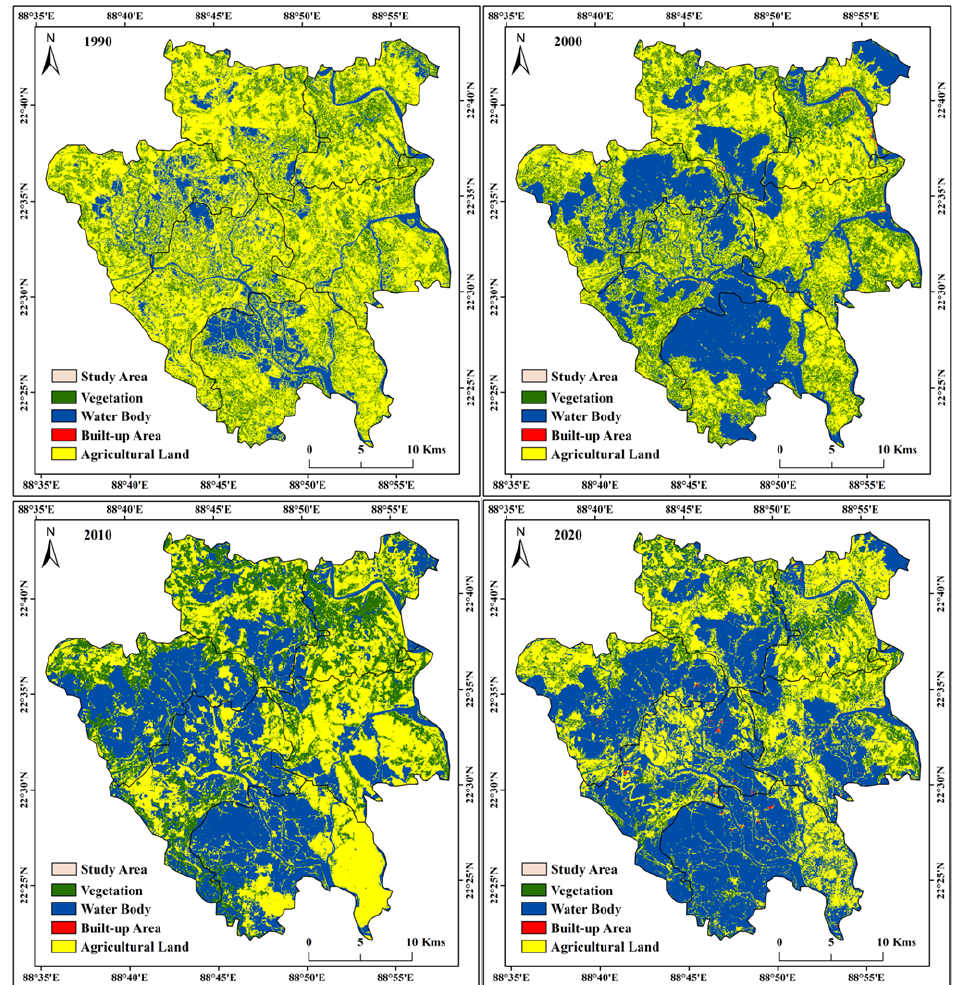
Figure 3. Land use and land cover classification maps of different time periods in the study area like 1990, 2000, 2010, and 2020.